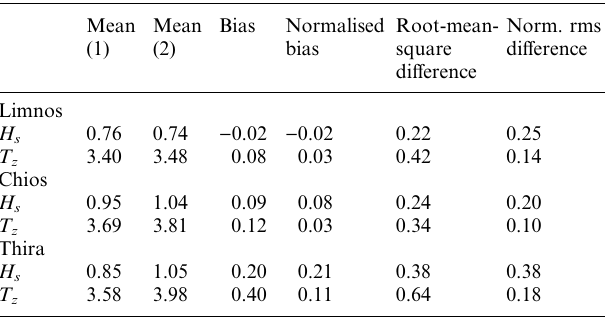
Table 8. Statistics for the storm December 1991, -128 points. Comparison of results from WAM-cy3 model using UKMO GLO